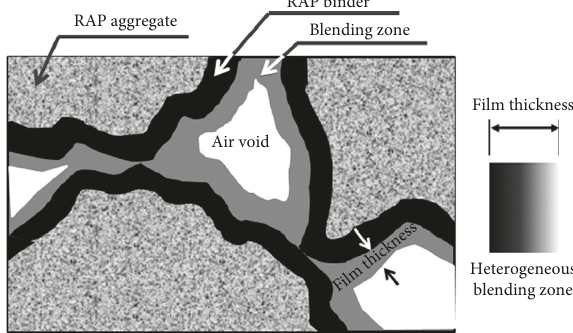
Figure 7: Microstructure of heterogeneous blending